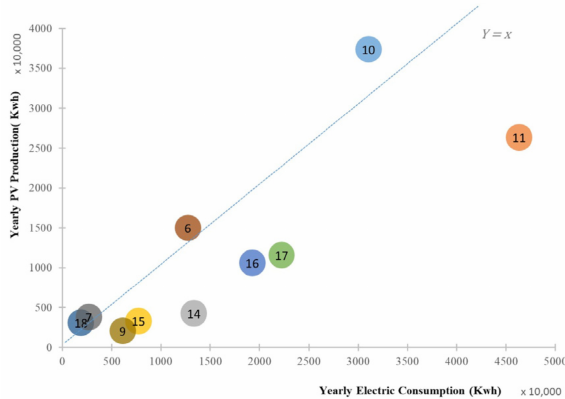
Figure 8. Assessment of the energy balance in each neighbourhood in Laghouat.